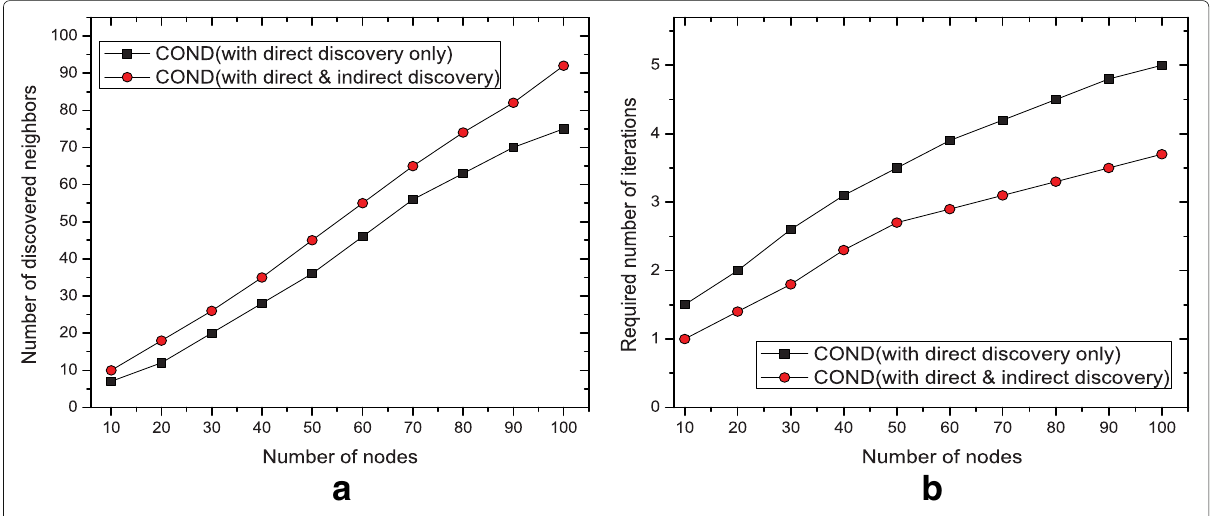
Fig. 4 Theoretical analysis for varying number of sensor nodes. a Neighbor discovery. b Required